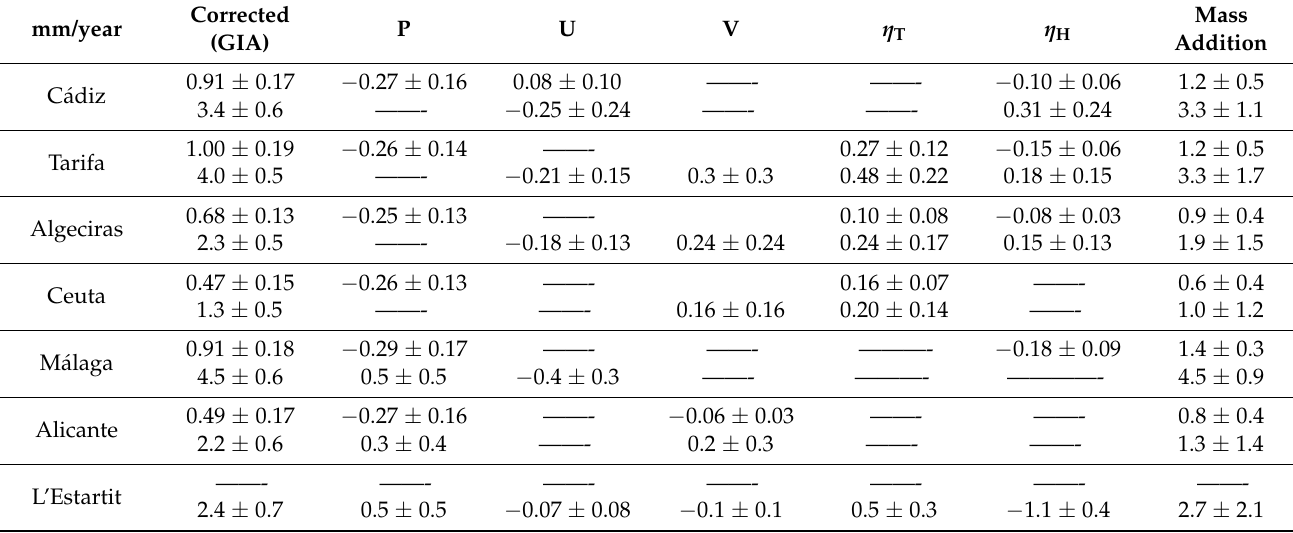
Table 5. Linear trends in mm/year and the contribution of each variable to the observed local sea level, corrected for the GIA. The second column shows the observed sea level trend corrected for GIA. Columns 3 to 7 show the contributions of P, U, and V and the thermosteric and halosteric components to the observed sea level. Column 8 is the sea level trend caused by mass addition. This column is equal to the second one minus columns 3 to 7. In all the cases, the first line corresponds to the period 1948–2018, and the second line corresponds to the period 1990–2018. When a variable does not contribute to the sea level trend because such variable experienced no trend or because it was not selected in the model, the table is filled with a